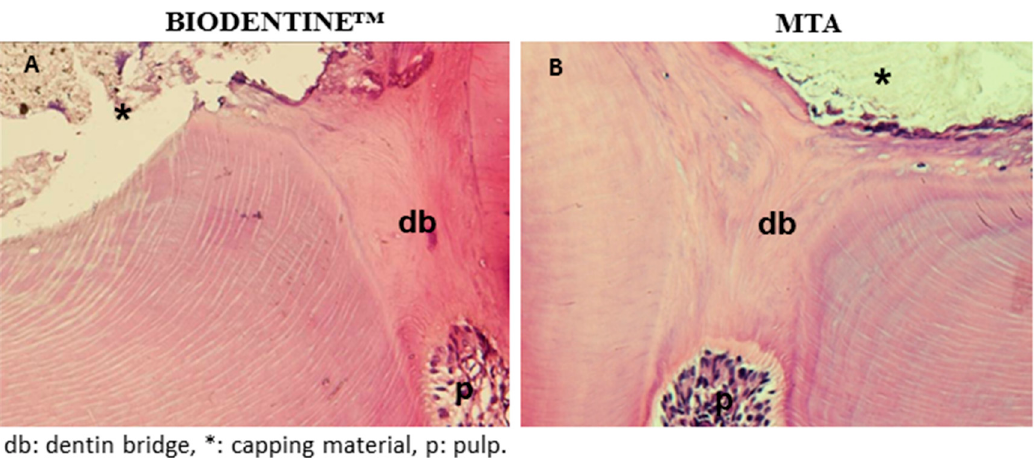
Figure 1. Hematoxylin eosin (HE)-stained sections of reparative dentin bridge: HE-stained sections of the Biodentine ™ group ( A ) and the mineral trioxide aggregate (MTA) group ( B ) showed a homogeneous and continuous mineralized barrier between the dental pulp and the capping material.